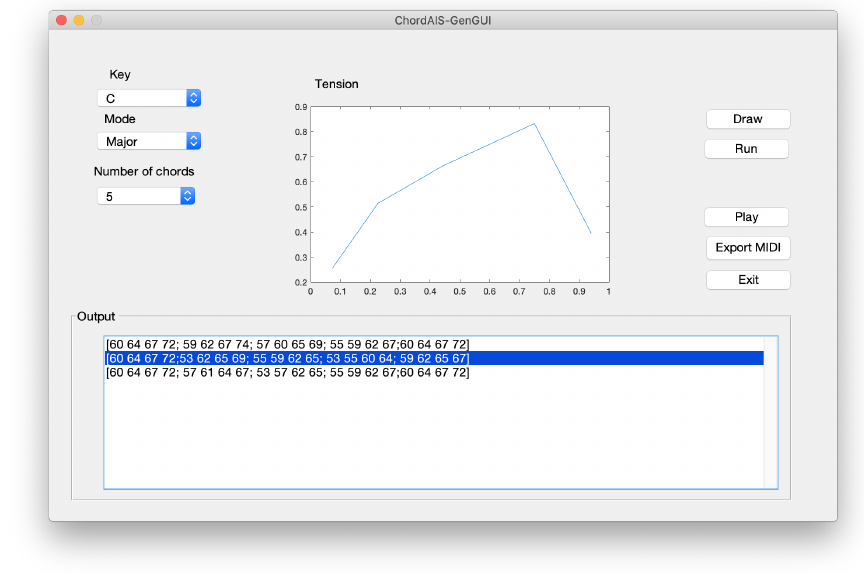
Figure 7. Interface of